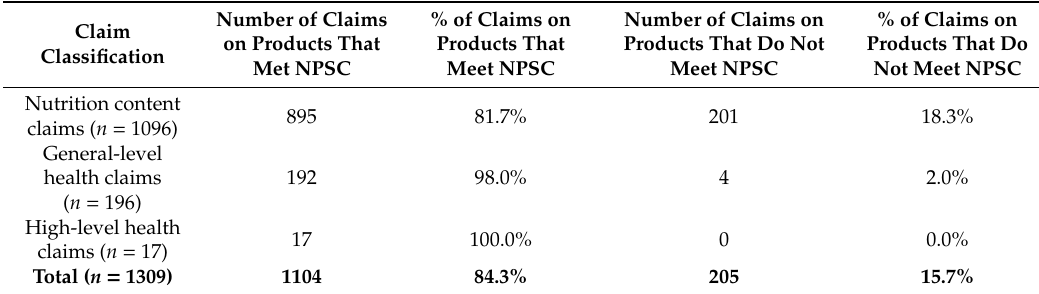
Table 3. Nutrition and health claims carried on products in the supermarket audit according to product classification with the NPSC.